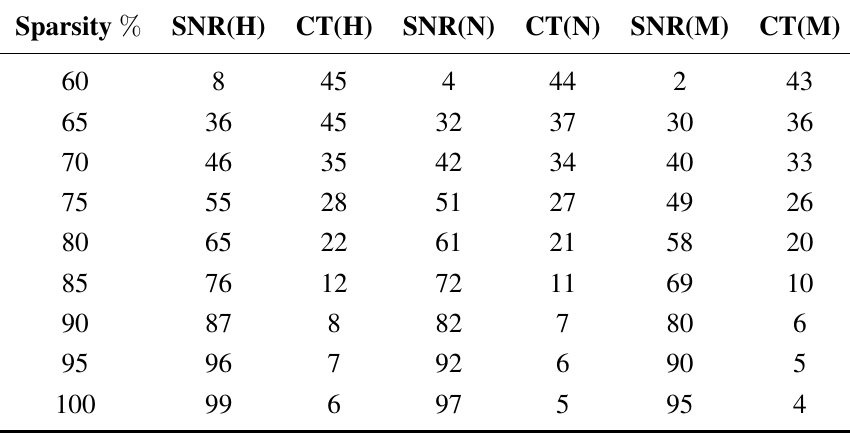
Table 7. Comparison on SNR and